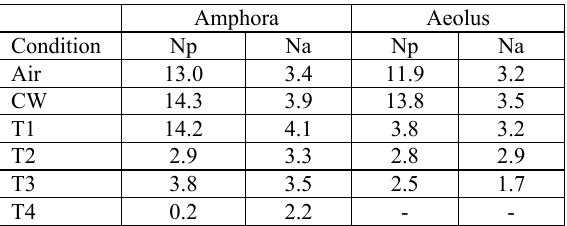
Table 2.: Acquired 3D points per 100 pixel for Aeolus with passive (Np) and active (Na) stereo technique. Npc% and Nac% are the percentage values of deleted points for both techniques.